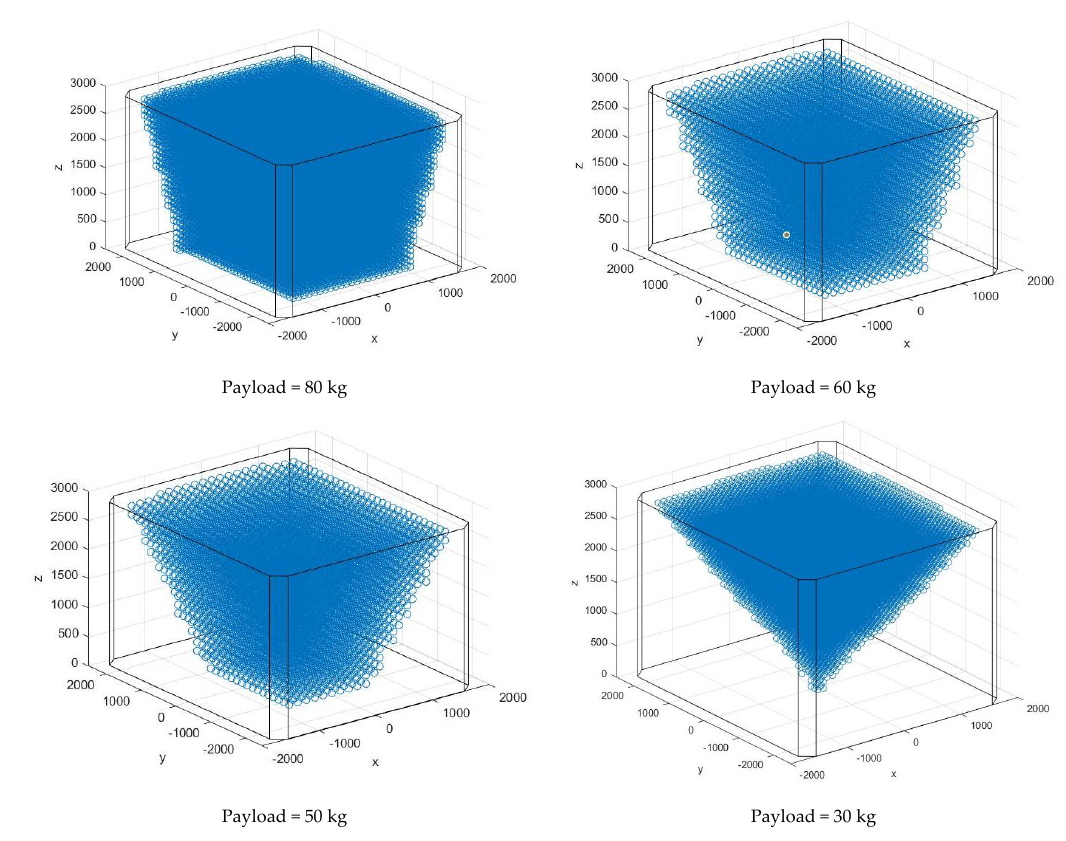
Figure 5. Wrench static workspace of the cable robot with a payload of 80 kg, 60 kg, 50 kg, and 30 kg.